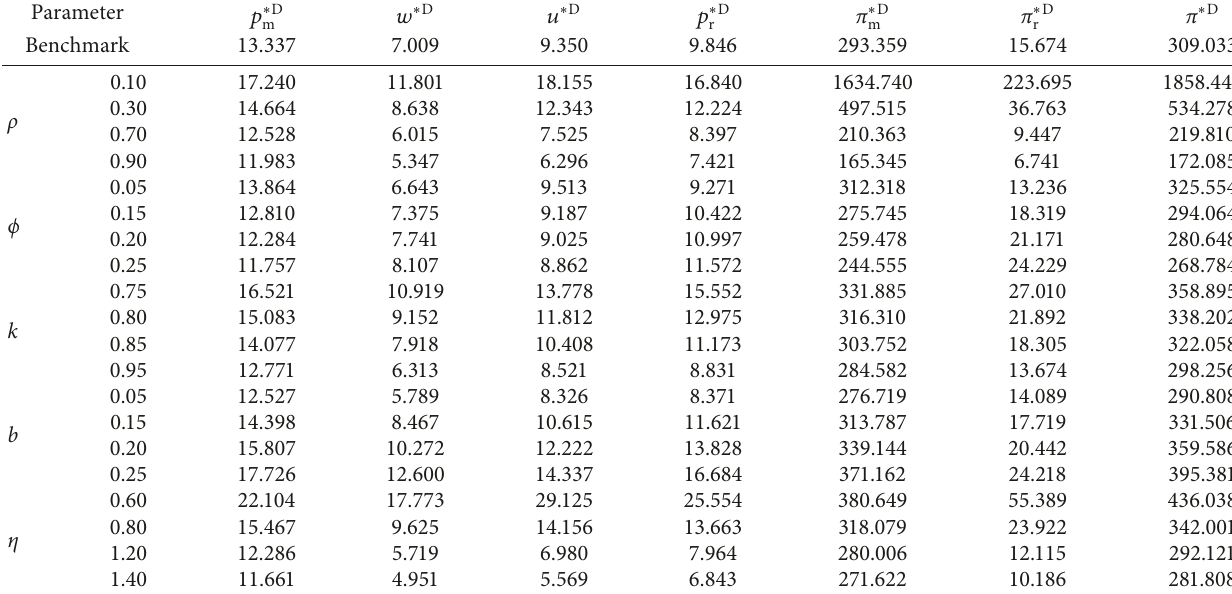
Table 1: Steady-state decisions and profits under dynamic pricing.